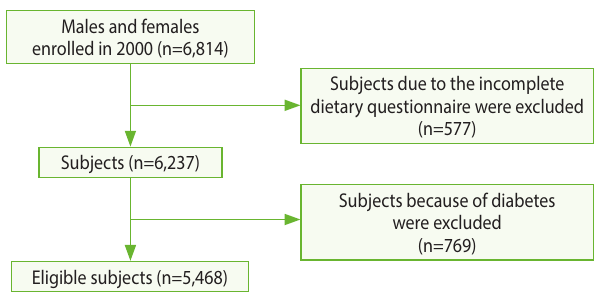
Figure 1. Flowchart for selection of study participants from the Mul- ti-Ethnic Study of